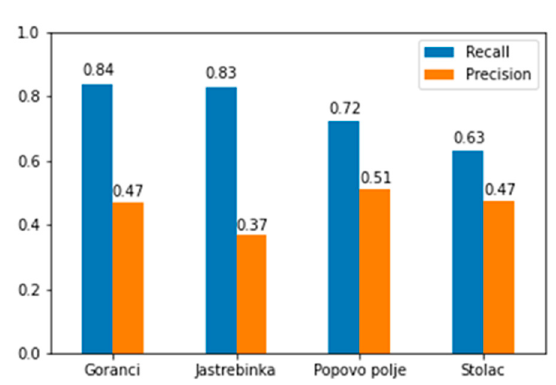
Figure 12. False-positive examples for the ScoreMap to ROI algorithm: ( a , c ) The algorithm, due to the shadow, made a wrong conclusion, ( b ) The stone and a blue plastic bag create an object that is almost impossible to distinguish from a human.